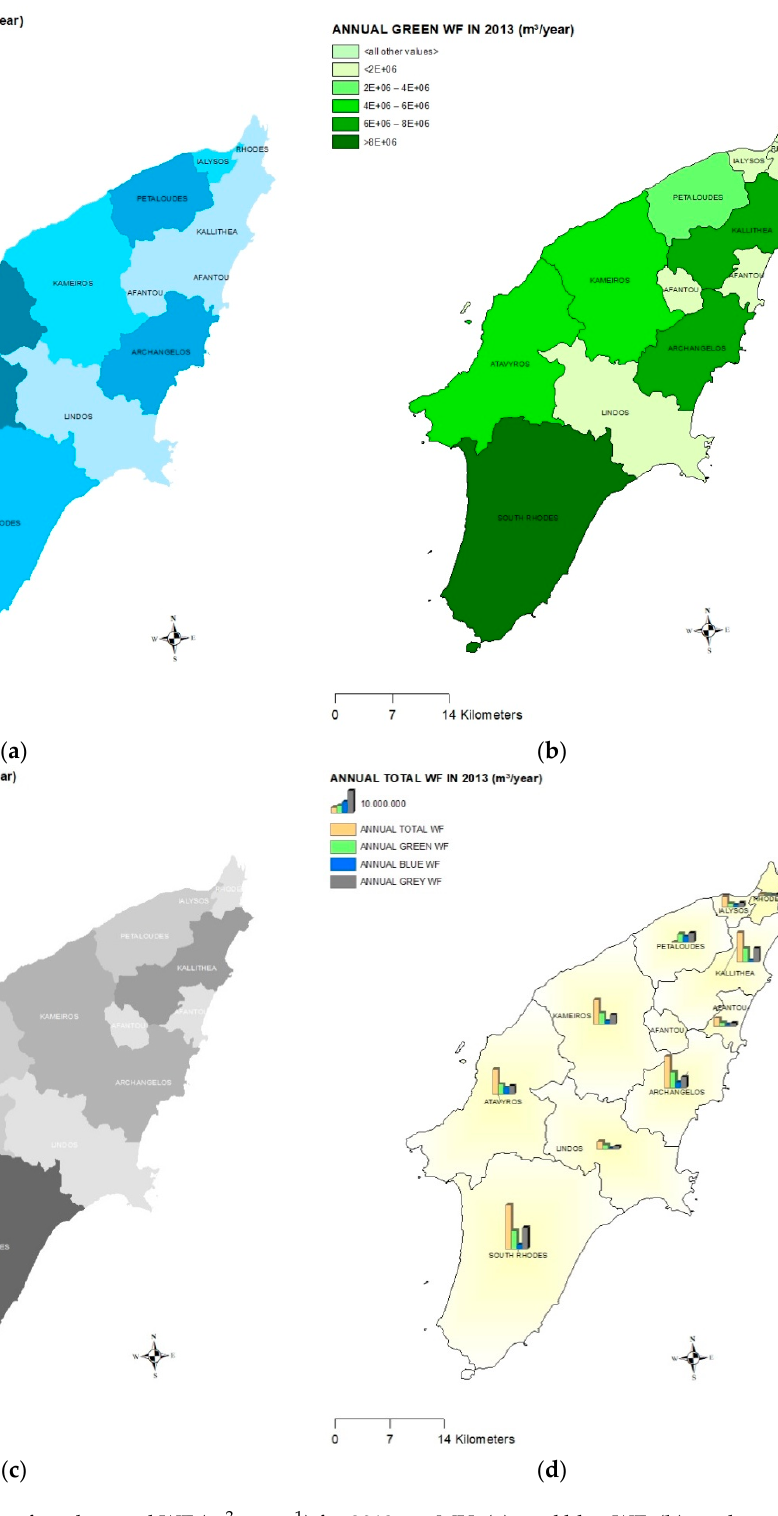
Figure 5. Distribution of total annual WF (m 3 year − 1 ) for 2013 per MU: ( a ) total blue WF; ( b ) total green WF; ( c ) total gray WF; and ( d ) total WF.